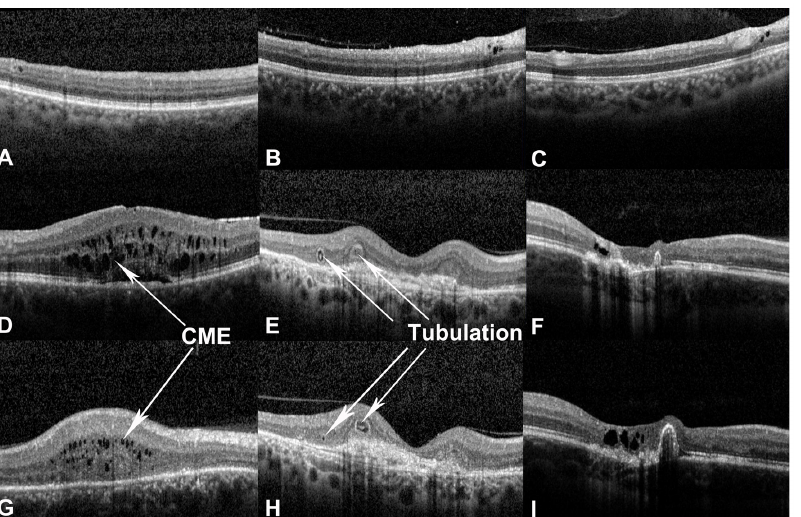
Figure 1. Case examples of cystoid space (CS) phenotypes in ocular toxoplasmosis as seen on optical coherence tomography (OCT). [ A–C ] Examples of cystoid degeneration next to retinal vessels in the inner retina. Figure B was from the right eye of an 18 year-old woman. She was with a previous diagnosis of ocular toxoplasmosis and presented with decreased vision of one week’s duration in the same eye. VA in the right eye was 20/25. Examination of the fundus of the right eye revealed vitreous cells, and an active creamy yellow lesion (about 1/3 disc diameters in size) with retinal hemorrhage on the nasal aspect of the optic disc with temporal optic nerve head swelling. Macular was with no obvious abnormality. OCT imaging of the right macula demonstrated an ERM with a few punctate spots in the vitreous, intraretinal CSs (in one B-scan, adjacent to a retinal vessel), along with absence of other retinal abnormalities. [ D, G ] Examples of cystoid macular edema (CME). Figure G was from the right eye of a 51 year-old man presenting for a regular follow-up examination of ocular toxoplasmosis. He had previously been diagnosed with ocular toxoplasmosis affecting the right eye at 17 years old. In his right eye, VA was 20/125 and anterior segment examination was unremarkable. Dilated fundus examination revealed a central macular scar with no findings suggestive of disease activity. OCT imaging showed multiple small CSs in the OPL and ONL, with increased retinal thickness, and categorized as CME. [ E, H ] Examples of outer retina tubulation. Figure E and H were from the right eye of a 70 year-old man, with a previous diagnosis of bilateral ocular toxoplasmosis. On examination, his VA was 20/20 on the right eye. Fundus examination revealed an old macular scar in the right eye without signs of disease activity. The patient had been diagnosed with choroidal neovascularization (CNV) secondary to age related macular degeneration in 2011 and treated with three injections of intravitreal ranibizumab (Lucentis, Genentech, USA) to the right eye. OCT imaging of the right eye demonstrated outer retina tubulation in the degenerated outer retina. [ F,I ] Examples of cystoid degeneration next to old